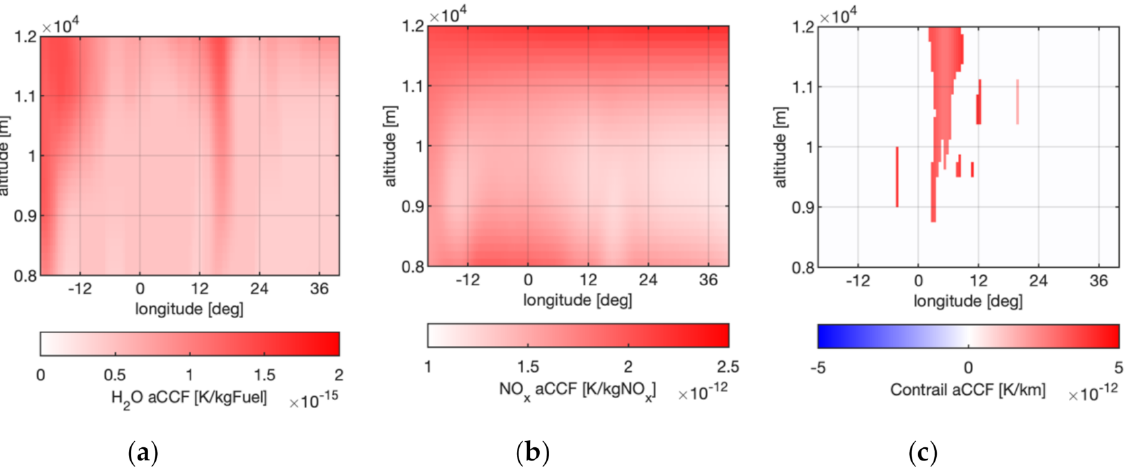
Figure 2. Algorithmic climate change functions for H 2 O ( a ), NO x ( b ), and contrails ( c ) on 18 December 2015, 6.00 p.m. UTC as function of longitude and altitude at 48 ◦